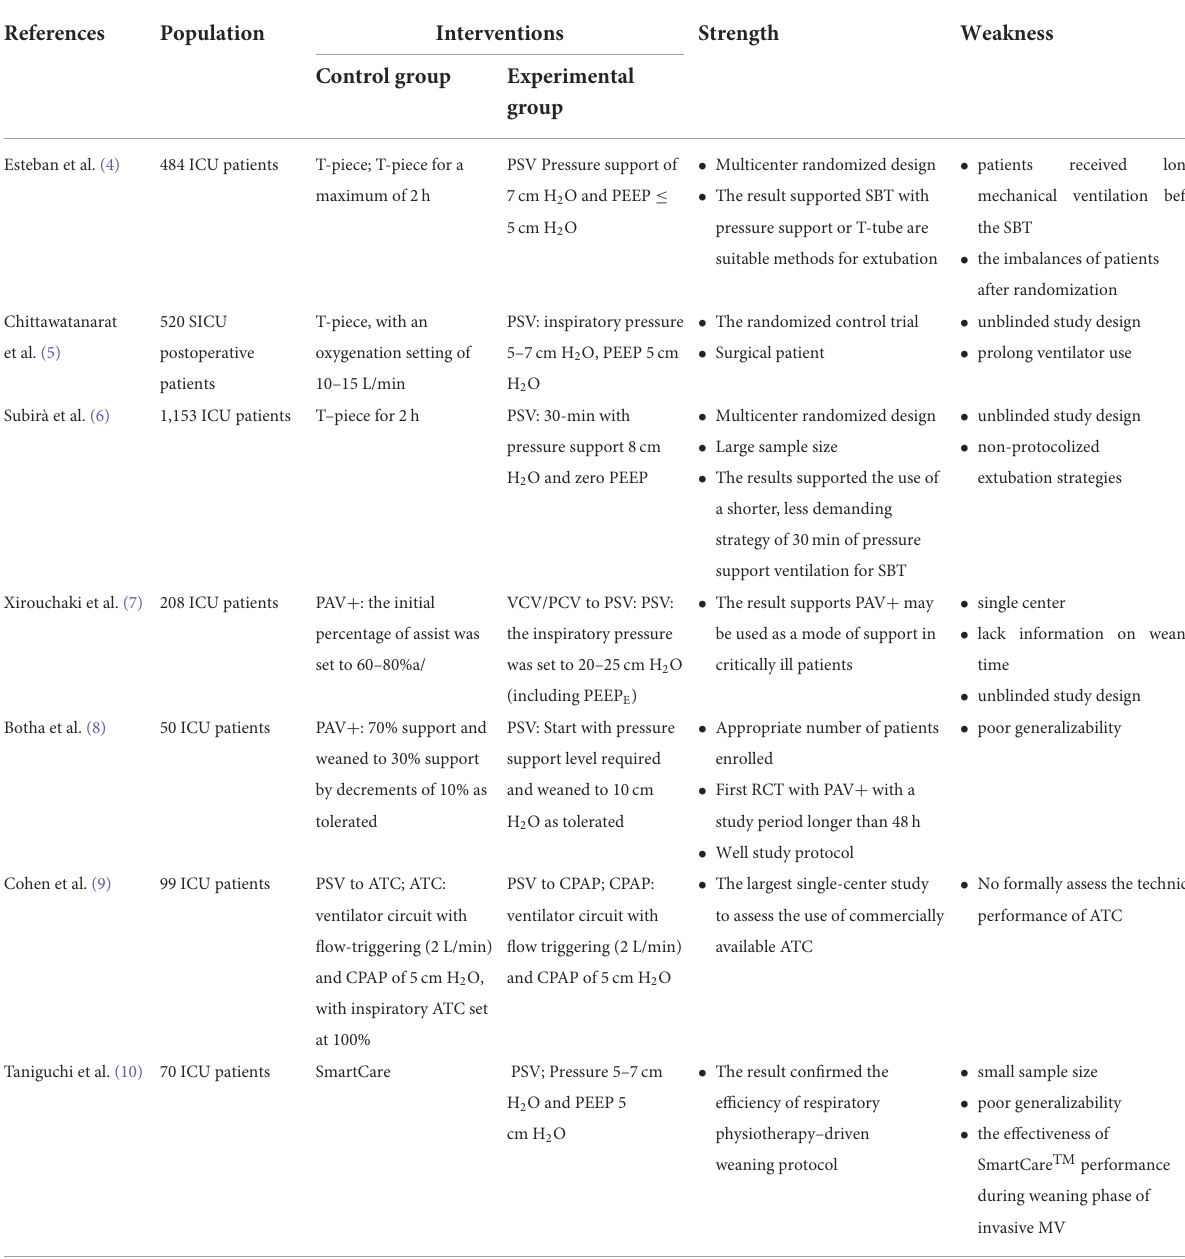
TABLE 1 Features of pivotal clinical